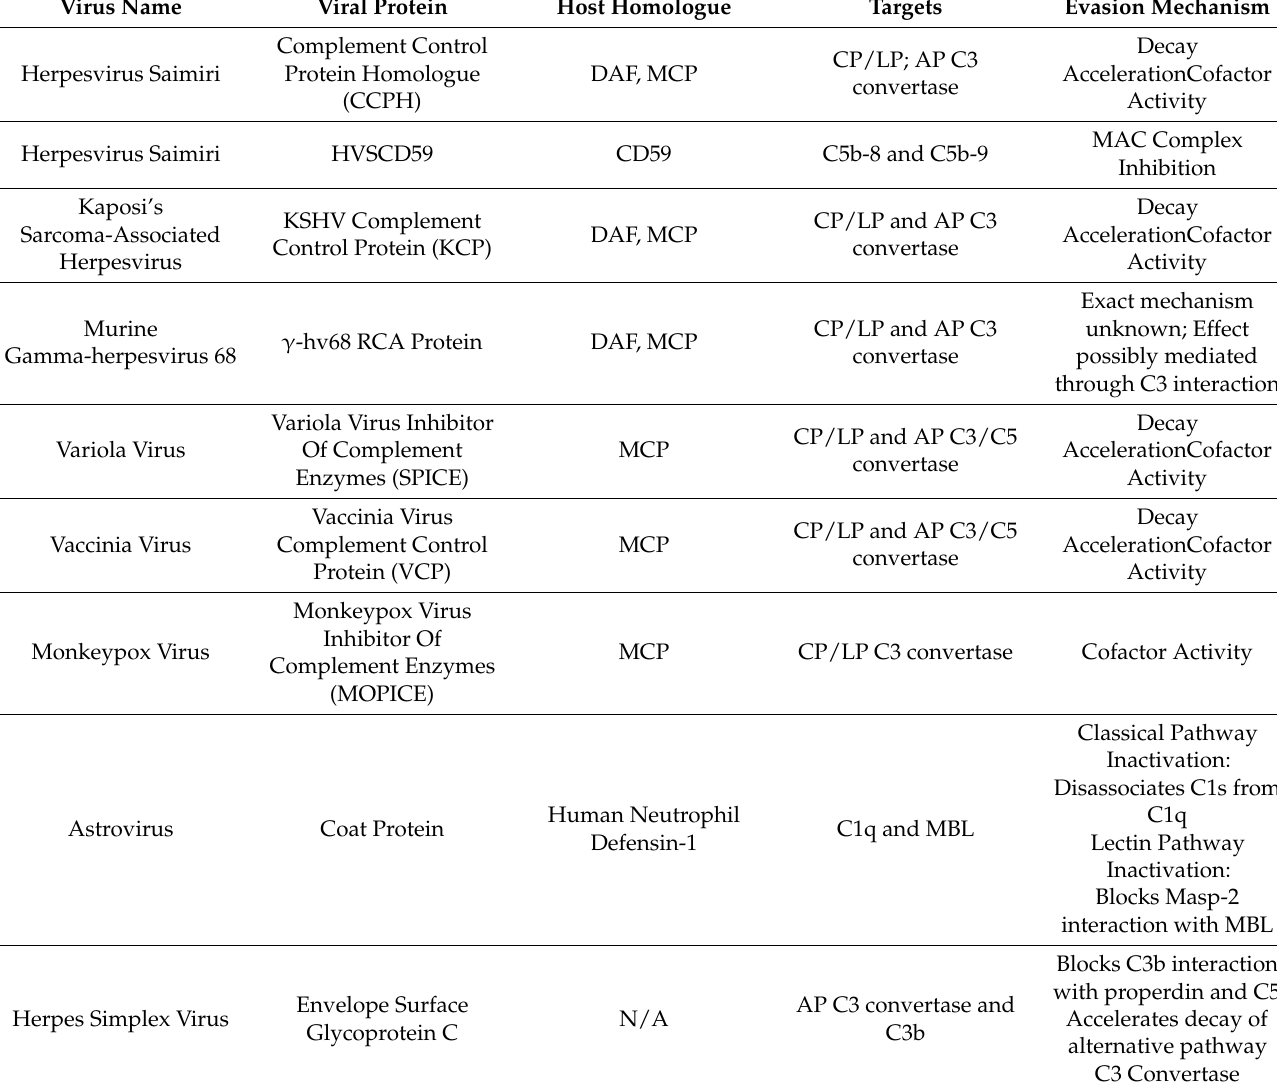
Table 2. Viral complement evasion proteins, their homologues and evasion